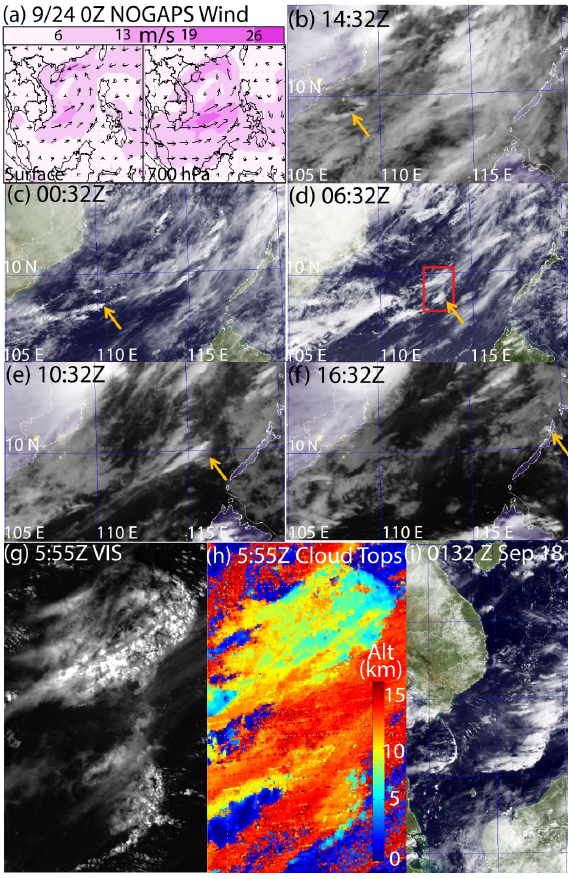
Figure 11. Day visible and night infrared time series of 24 Septem- ber squall line/cold pool event. (a) 24 September 0Z NOGAPS surface and 700hPa winds at event initiation. (b) 23 September 14:32UTC cold pool arc cloud propagating south from Ho Chi Min City initiated thunderstorm. (c) 24 September 00:32UTC, con- vective cell spawned by cold pool, propagating to the NNE; (d) 24 September 06:32UTC cold pool from cell in (c) ; (e) convective cell spawned by cell in (e) ; (f) final cell spawned by cold pool from (e) sampled by Vasco ; (g, h) 250m MODIS Aqua Ch 1 visible and derived cloud height product respectively. Inset in (d) is the domain. (i) 18 September 01:32UTC MTSAT image of extensive latitudinal dimension of two squall line